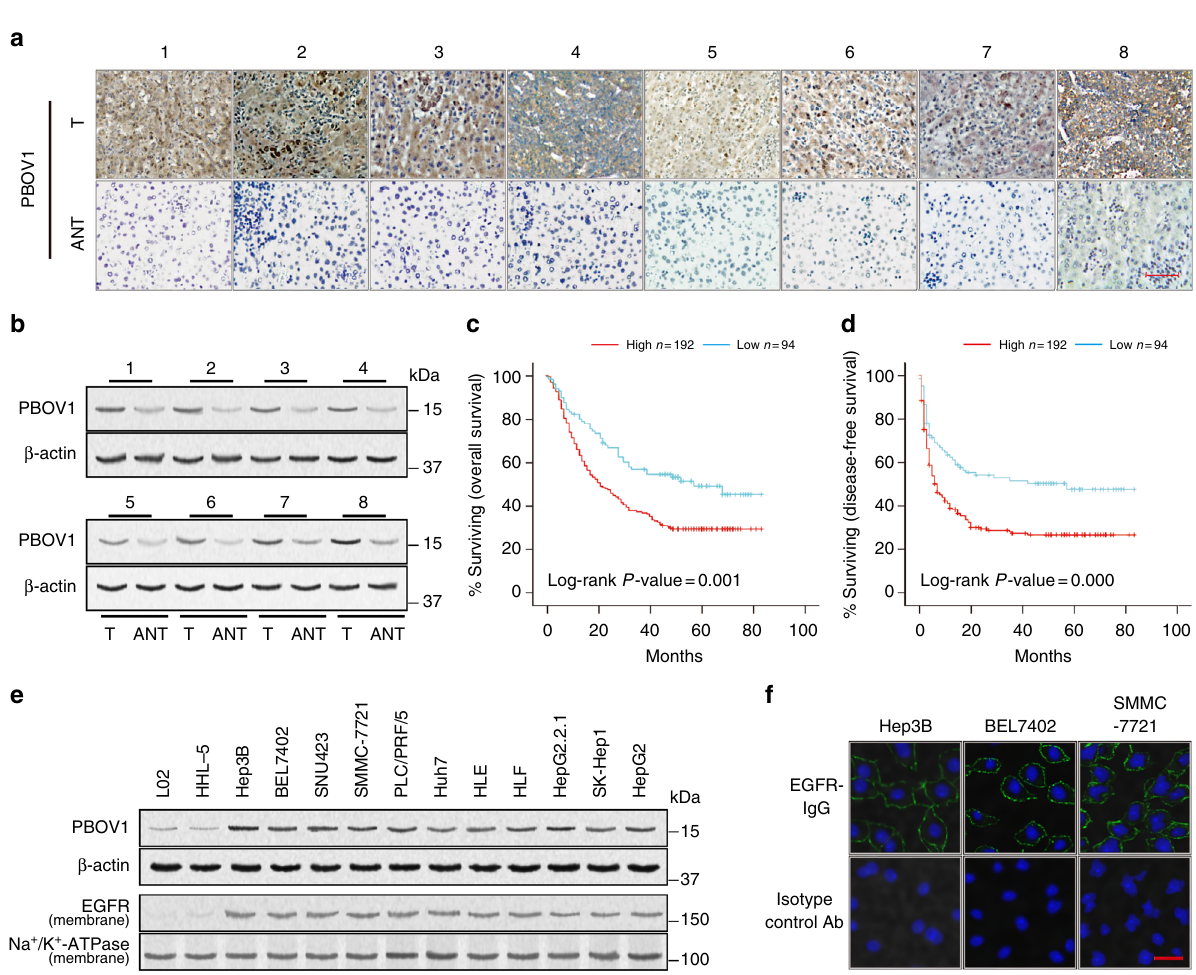
Fig. 1 Clues of elevated expressions of PBOV1 and EGFR in HCC clinical specimens and cell lines. a Immunohistochemical stain (IHC) analysis of prostate and breast cancer overexpressed 1 (PBOV1) protein expression in each of the hepatocellular carcinoma (HCC) tissues (T) and adjacent nontumor tissue liver tissues (ANT) paired from the same patient. Scale bar, 100 μ m. b Western blotting analysis of PBOV1 protein expression in HCC tissues and paired ANT liver tissues from the same patient. c Overall survival of HCC patients with low PBOV1 expression versus patients with high PBOV1 expression ( n = 286, P < 0.05, log-rank). d Disease-free survival of HCC patients with low PBOV1 expression versus patients with high PBOV1 expression ( n = 286, P < 0.05, log-rank). e Expressions of PBOV1 and epidermal growth factor receptor (EGFR) determined by western blotting in the human normal hepatocyte cell lines (L02, HHL-5) and multiple HCC cell lines (Hep3B, BEL7402, SNU423, SMMC-7721, PLC/PRF/5, Huh7, HLE, HLF, HepG2.2.1, SK-Hep1, and